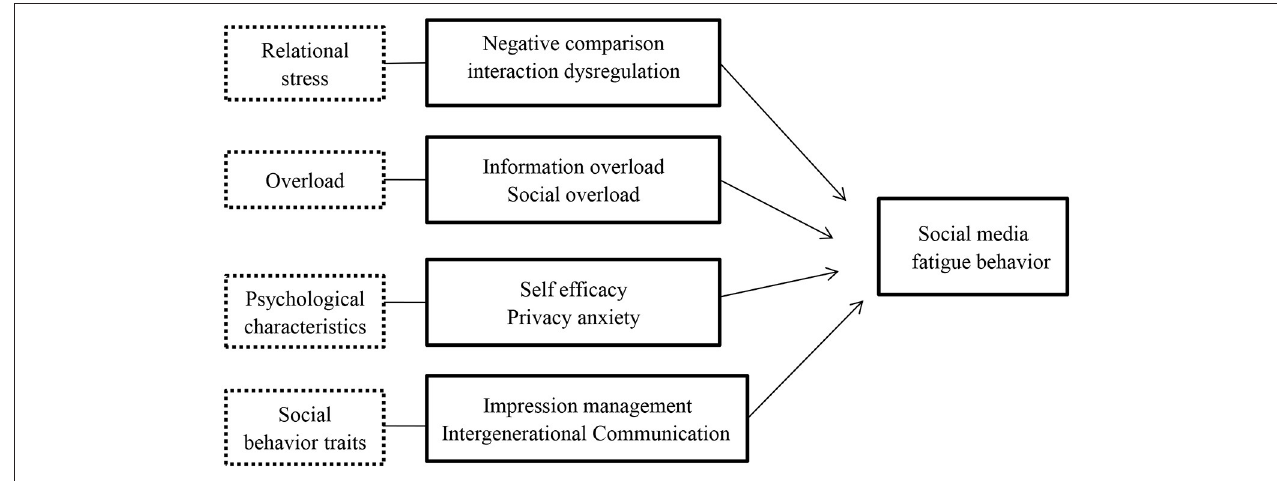
FIGURE 1 | Theoretical model.